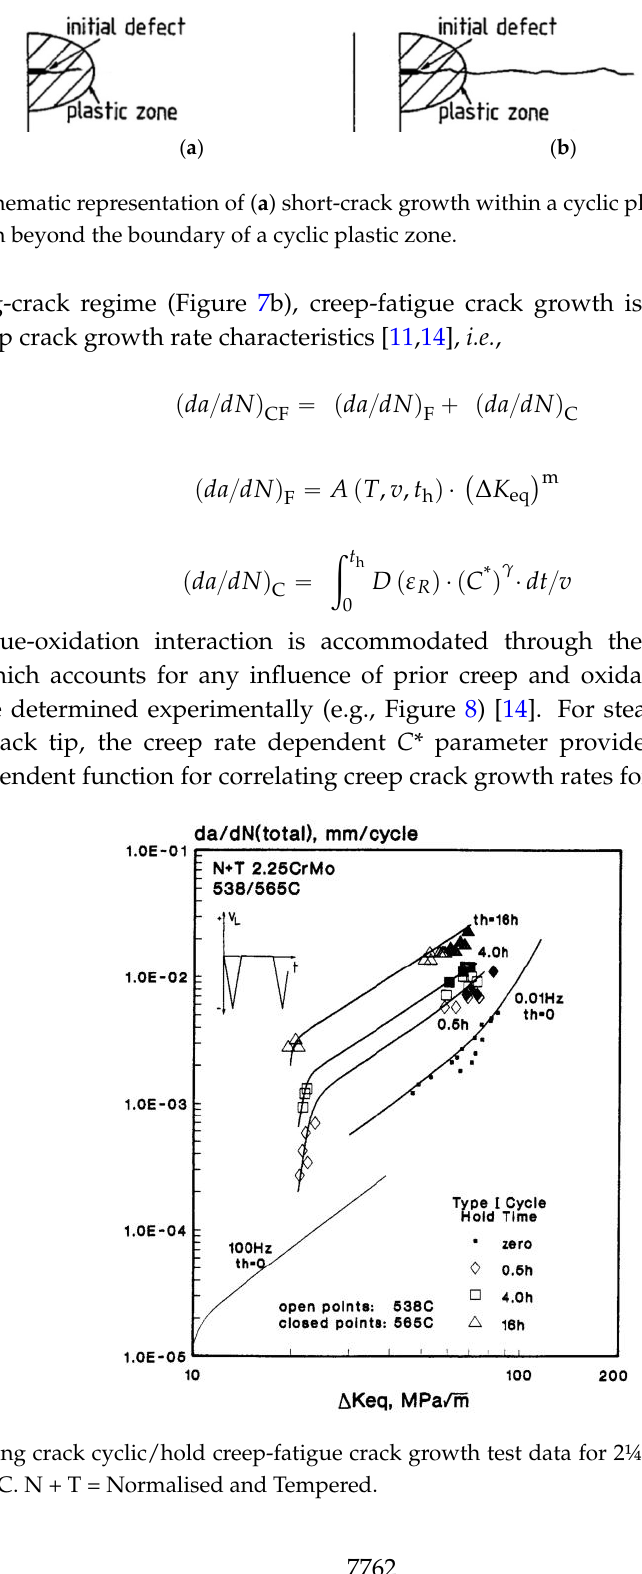
Figure 8. Long crack cyclic/hold creep-fatigue crack growth test data for 2¼ CrMo cast turbine steel at 538/565 °C. N + T = Normalised and Tempered.